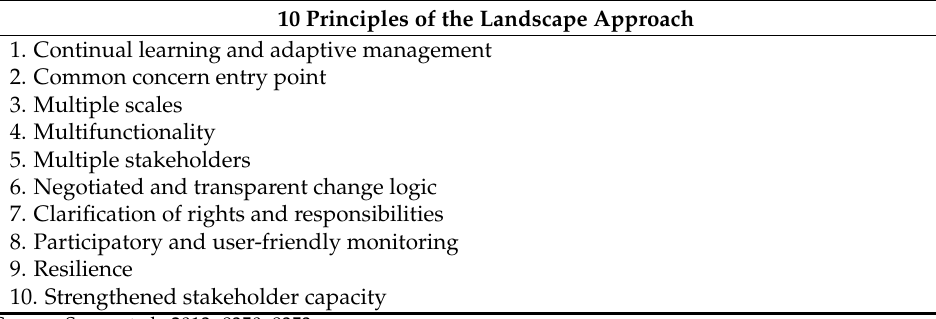
Table 2. Ten principles of the Integrated Landscape